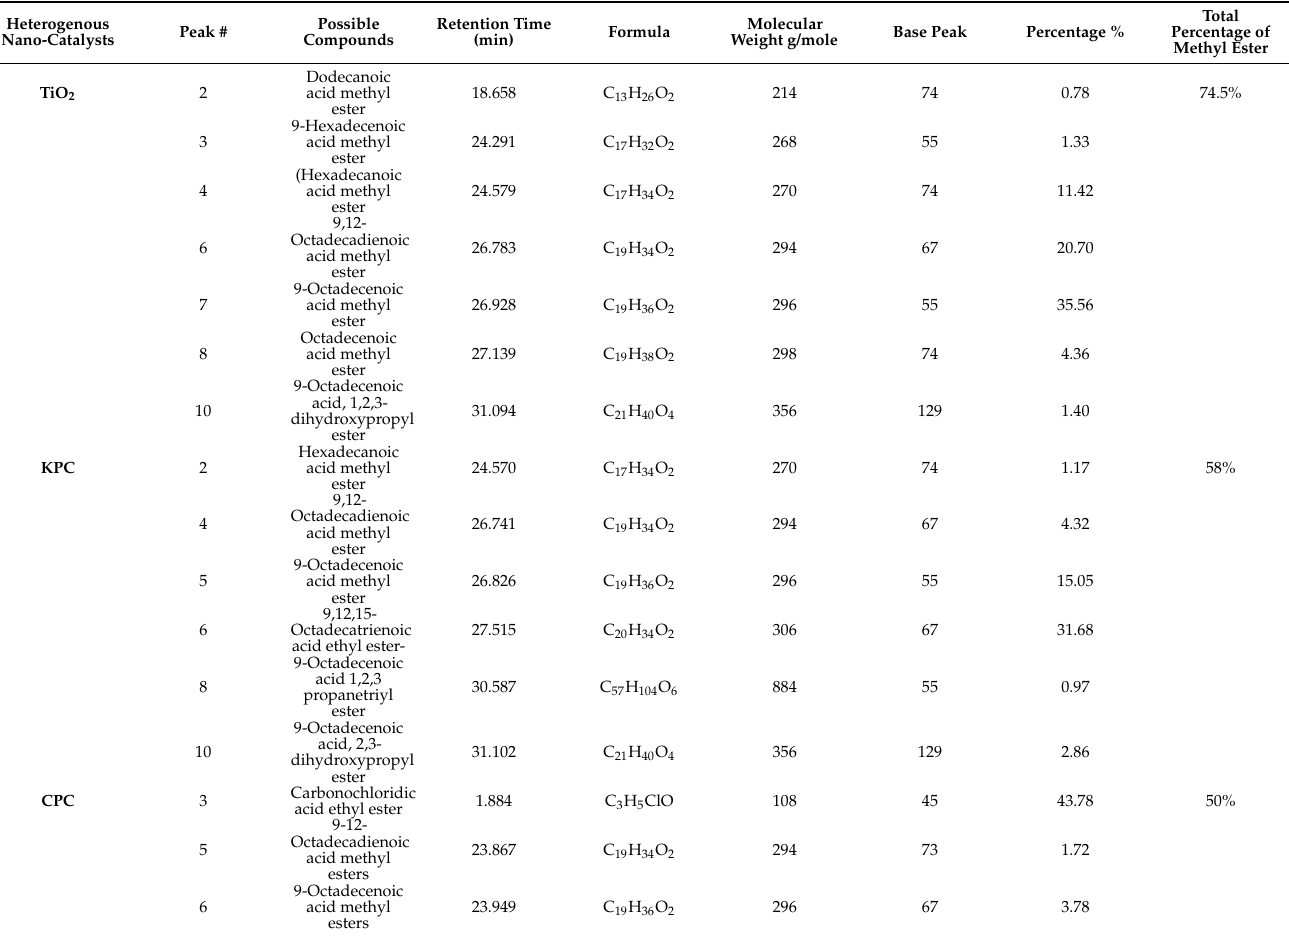
Table 5. Comparative analysis of Prunus aitchisonii FAMEs (fatty acid methyl ester) using heteroge- nous